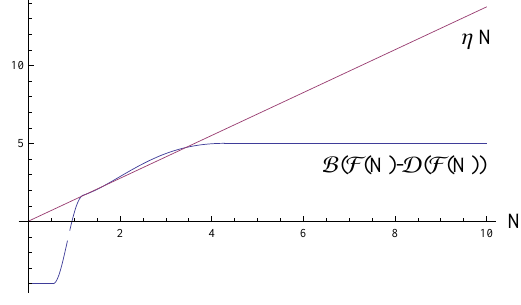
Fig. 11. When E ( F ) has three inflection points, then the model (4) can have up to four internal equilibrium points, depending on the value of K .